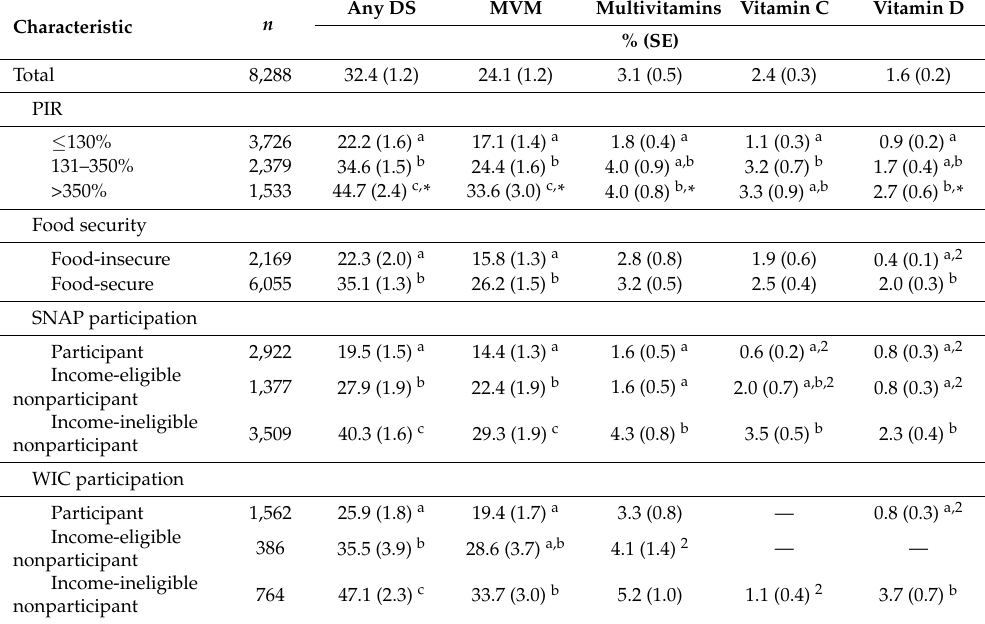
Table 2. Estimated percentage of U.S. children ( ≤ 18 years) who used dietary supplement in a 30-day period by economic indicators, NHANES 2011–2014 1,2